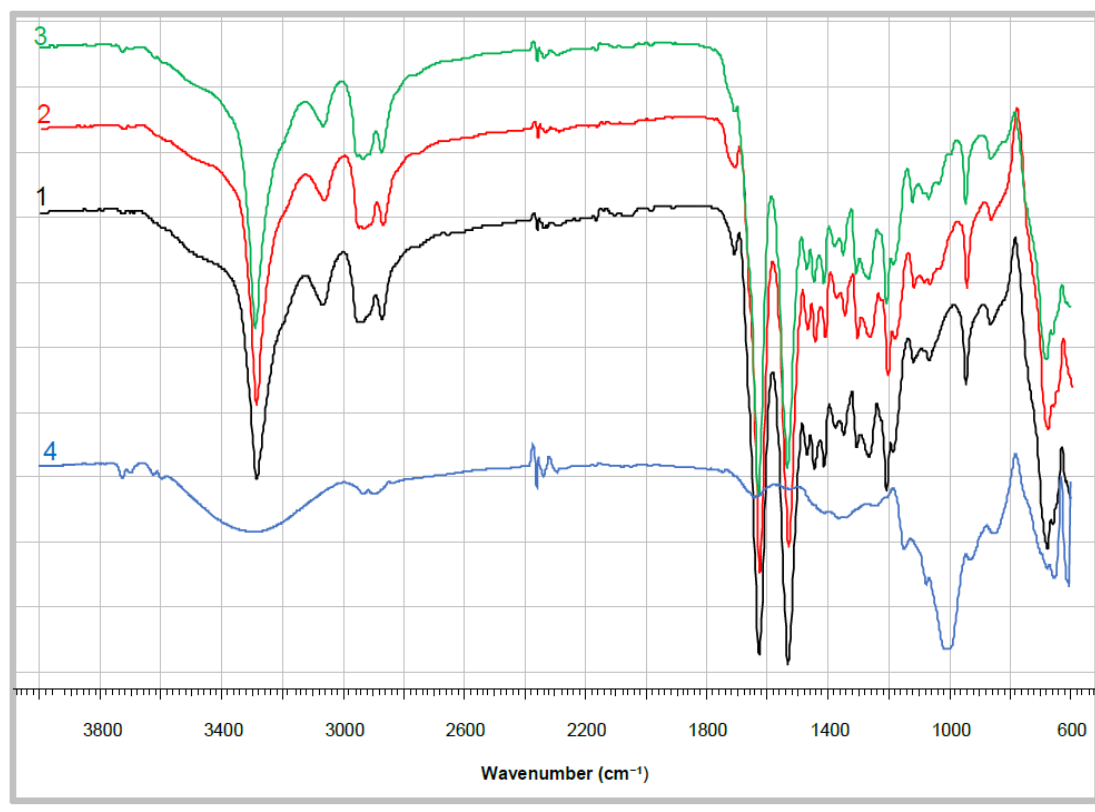
Figure 4. FTIR spectra with ATR of: 1—empty PA4 support; 2—PA4@iL; 3—PA4@eL; 4—native laccase.